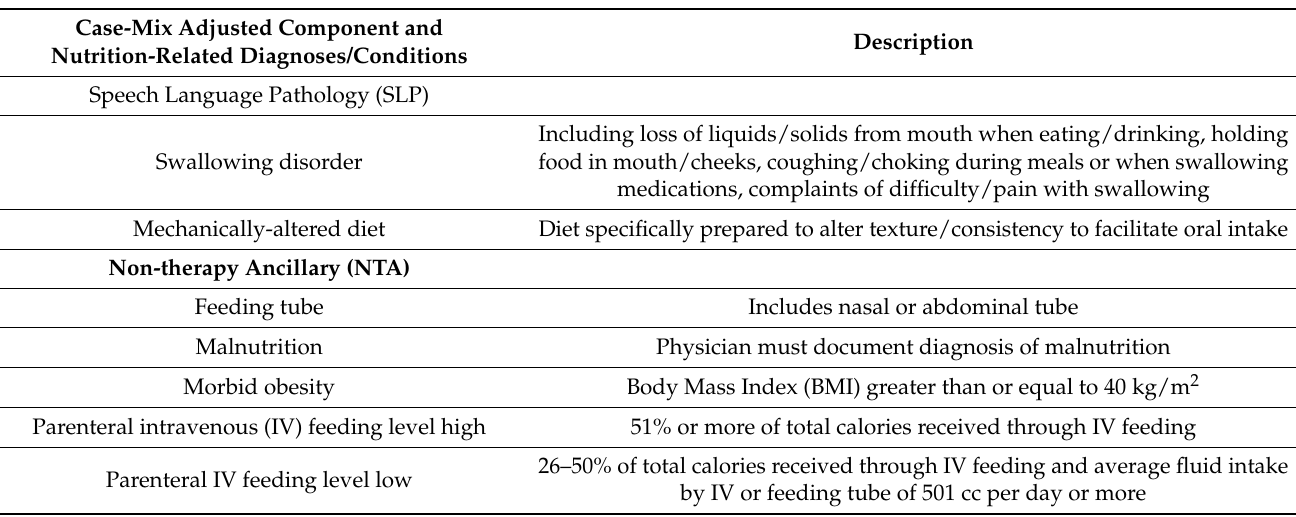
Table A1. Skilled Nursing Facility (SNF) Patient Driven Payment Model (PDPM) case-mix adjusted components that include nutrition-related diagnoses and